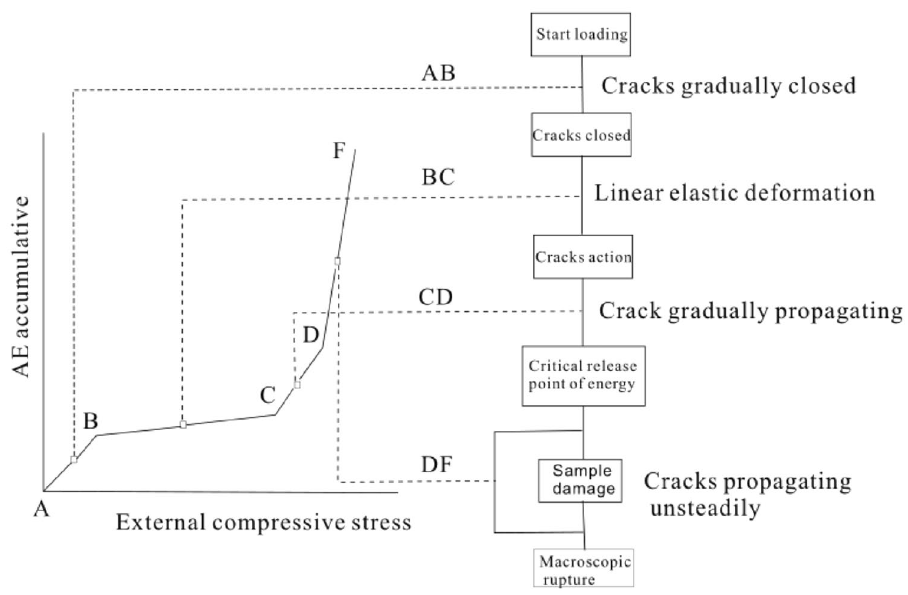
Fig. 7 General acoustic emis- sion mode in the process of rock